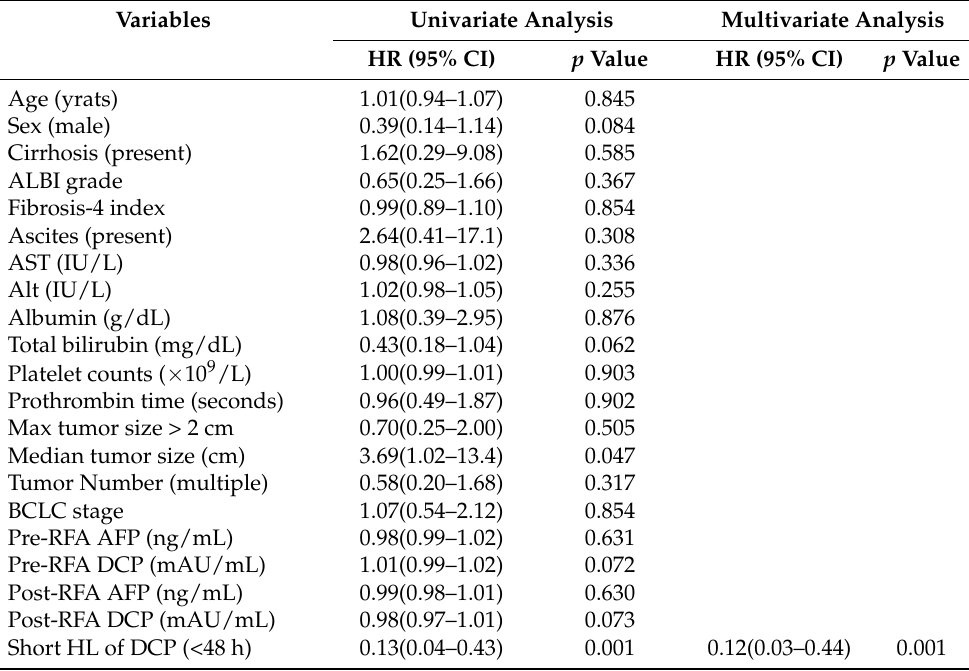
Table 4. Univariate and multivariate analysis of prognostic factors for recurrence-free survival. Variables Univariate Analysis Multivariate